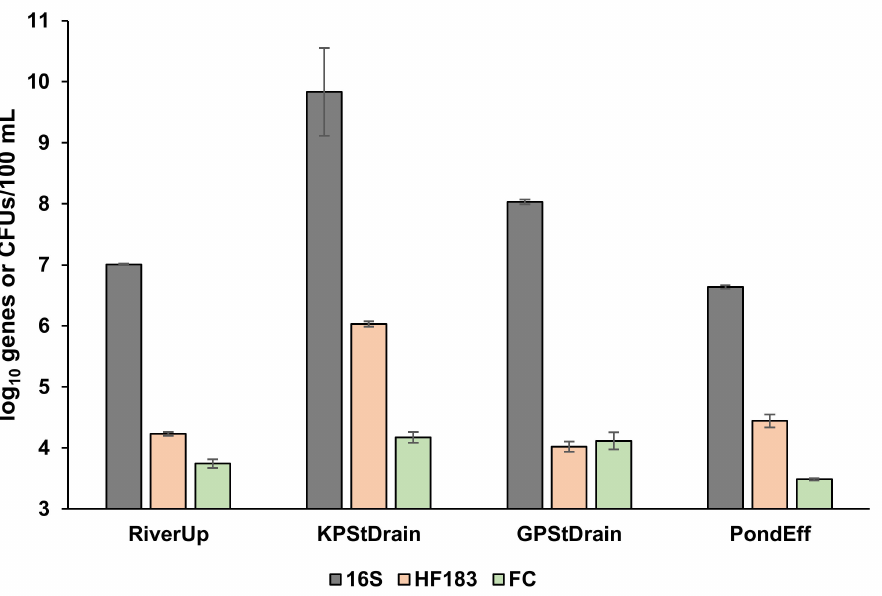
Figure 4. 16S rRNA and HF183 marker gene copies and FC per 100 mL of river (RiverUp), storm drain (KPStDrain and GPStDrain), and retention pond (PondEff) water quantified onsite, error bars indicate the standard deviation of